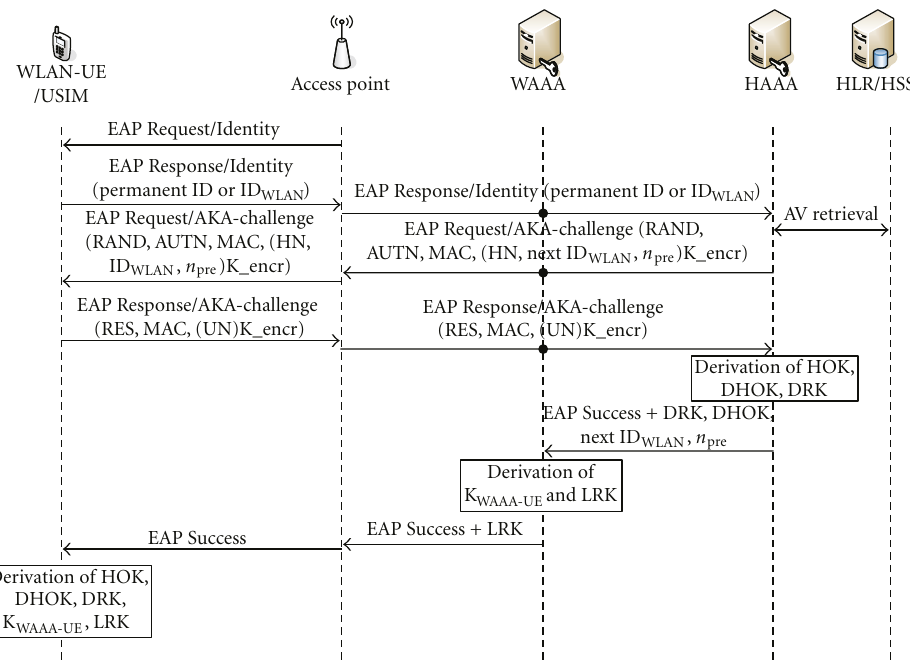
Figure 3: Modified EAP-AKA authentication